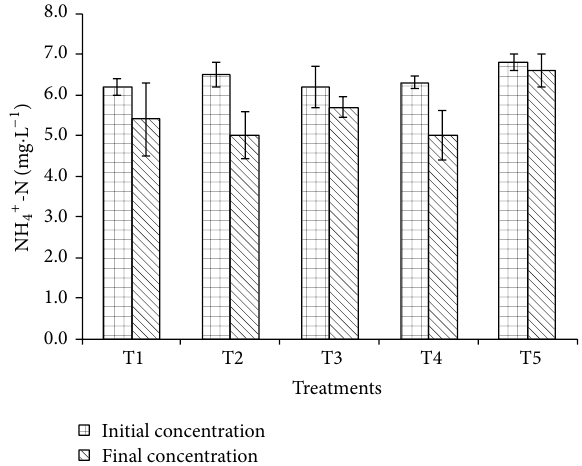
Figure 3: The change of the concentration of NH 4 + -N under controlled drainage at jointing-booting stage. The initial and final concentrations are the NH 4+ -N concentration in groundwater at the beginningofsubmergenceandendofdrainage,respectively.Vertical bars represent ± standard error (SE) of the mean.